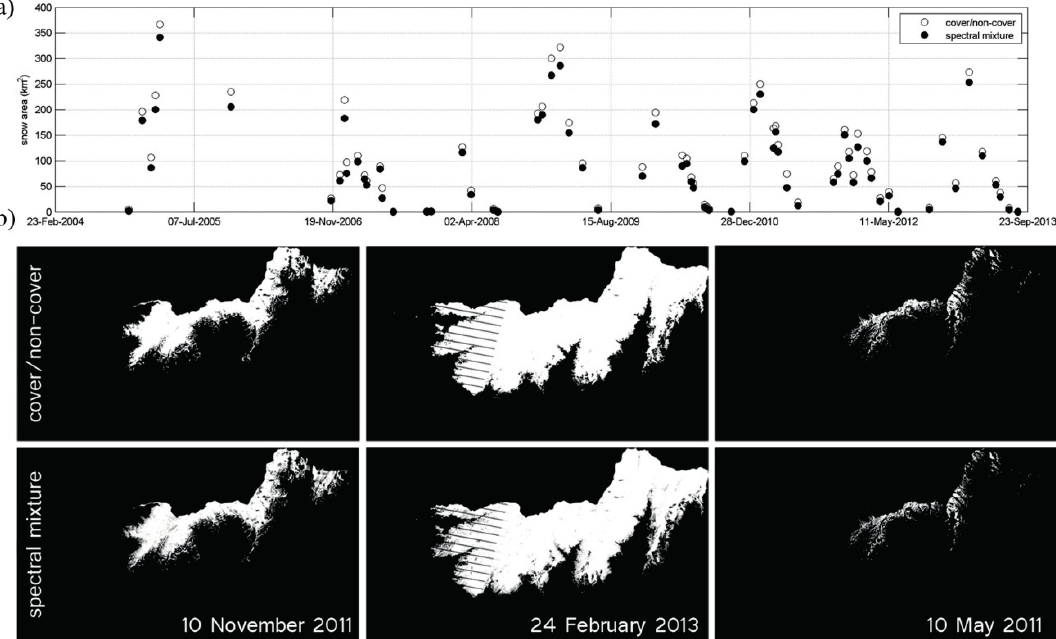
Fig. 2 Comparison between the snow area resulting from the covered-non covered analysis and the spectral mixture analysis for the Landsat images used in the study area. a) Temporal evolution, b) Selected snow maps for 10 November 2011, 24 February 2013 and 10 May 2011 (up, covered-non covered classification, and down, spectral mixture